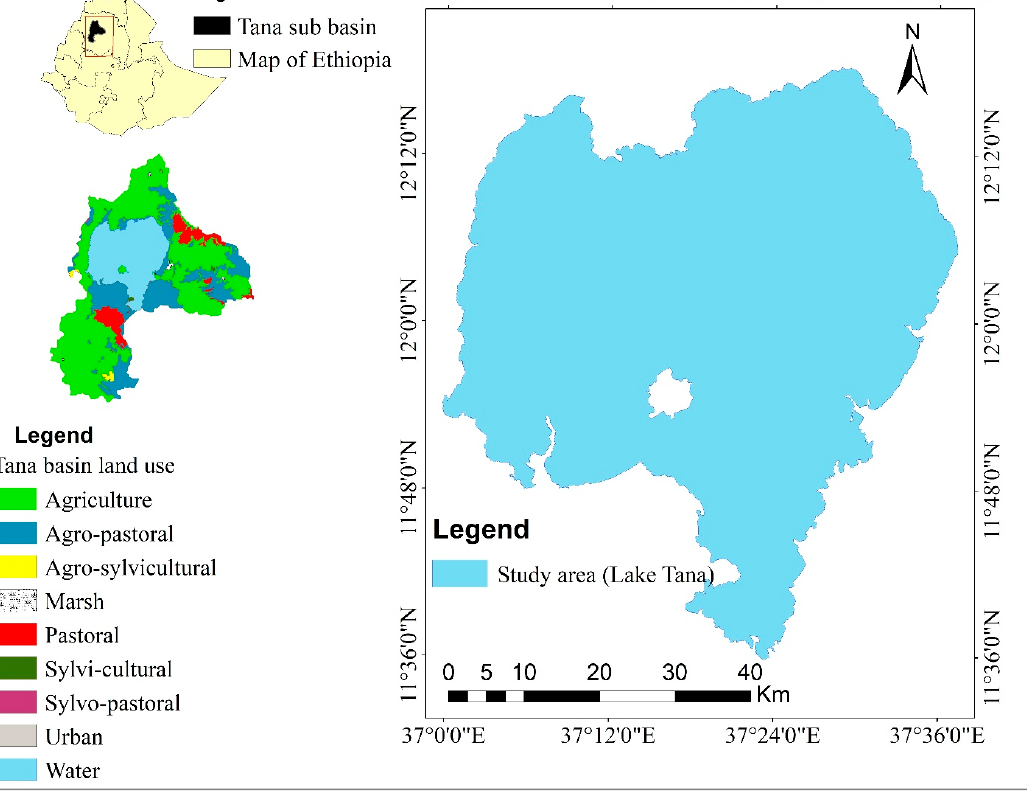
Figure 1. Tana basin land use and Lake Tana in the Upper Blue Nile basin (UBN), Northwestern Ethiopia.